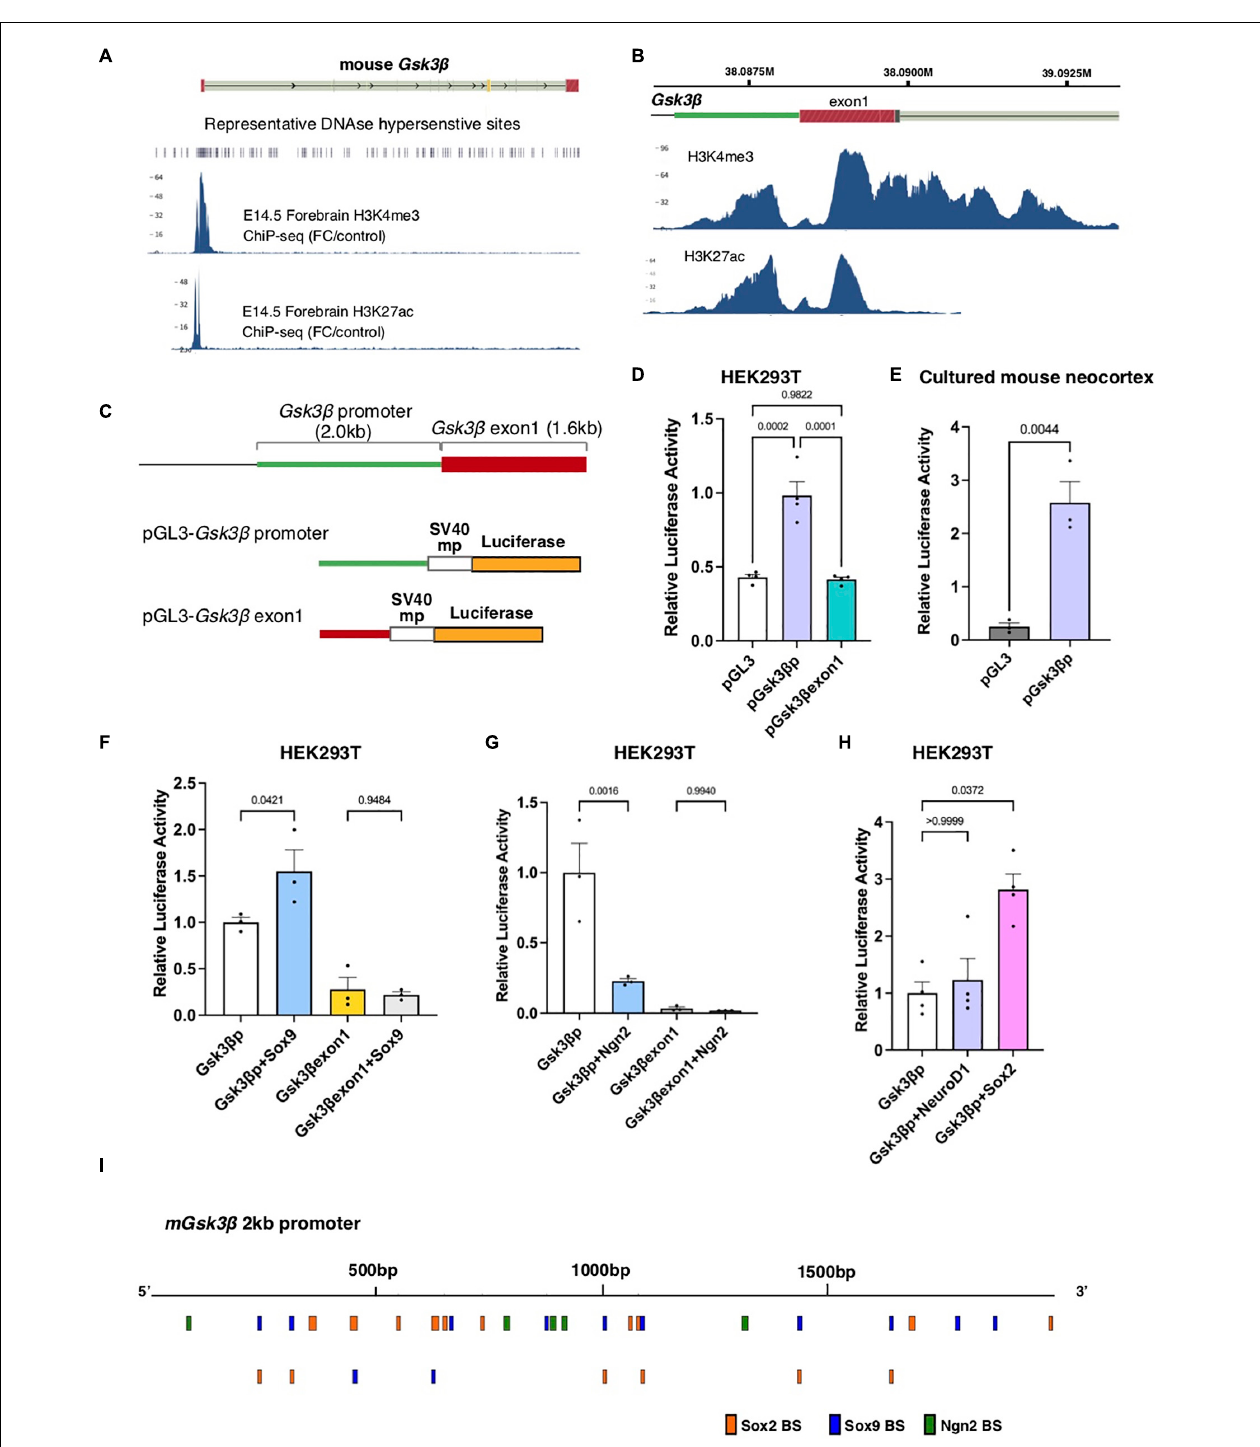
FIGURE 1 | The Gsk3 β promoter region acts as a CRM in response to cell type-specific transcription factors. (A,B) Histone ChIP-seq data of mouse E14.5 forebrain tissue focusing on the Gsk3 β genomic locus (ENCODE). The peaks represent H3K4me3 and H3K27ac enrichment. (C) Schematic drawings of the Gsk3 β promoter and exon 1 and reporter vectors containing these genomic fragments. (D,E) Luciferase activities of reporter vectors in HEK293T cells (D) and cultured mouse neocortex (E) . (F–H) Luciferase activities of reporter vectors containing the Gsk3 β promoter or exon 1 in response to cell type-specific transcription factors, including Sox9 (F) , Neurogenin2 [Ngn2, (G) ], NeuroD and Sox2 (H) . (I) Putative binding sites of Sox2, Sox9, and Ngn2 in mouse Gsk3 β promoter region. All graphs represent mean + s.e.m.; n = 3 or 4 independent samples. Statistical analyses were performed by ordinary one-way ANOVA (D,F,G) , unpaired t -test (E) , and Kruskal-Wallis test with Dunn’s multiple comparison’s test (H) . P -values are represented in each graph.